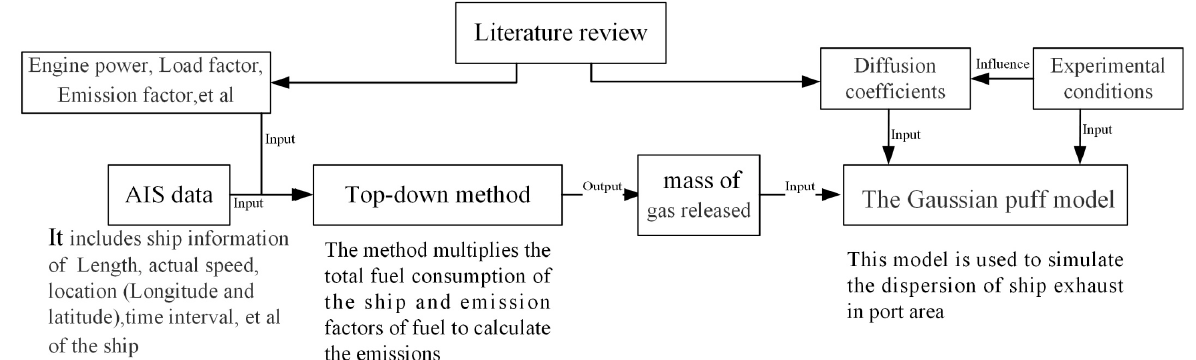
Figure 1. Technical method of diffusion model and calculation model of exhaust gas.